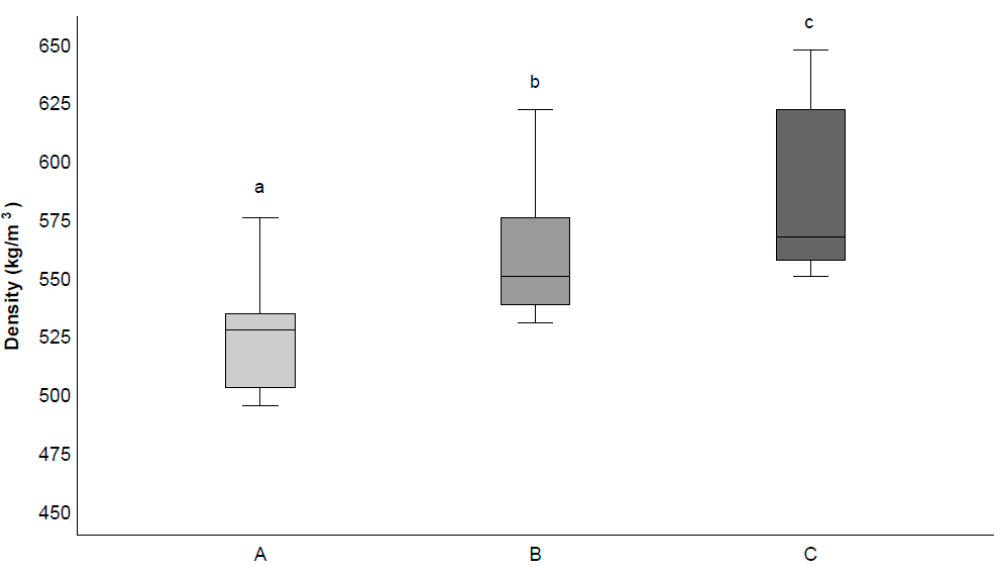
Figure 2. Density of OSB types [percentages of sweet chestnut wood (SC) and poplar (P) wood: A: 50% SC-50% P; B: 60% SC-40% P; C: 100% SC] grouped (a, b, c) based on statistical analysis (T-bars indicate maximum and minimum values).